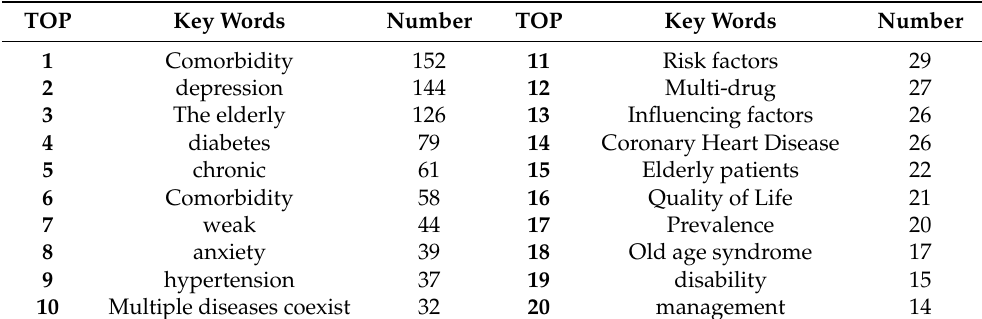
Table 5. Top 20 Frequency of Core Keyword in Chinese